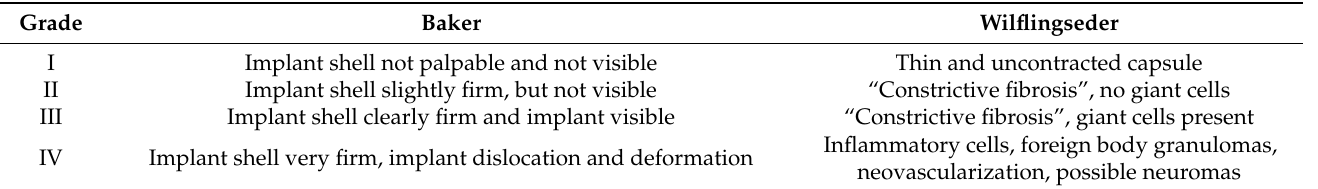
Table 1. Clinical classification (Baker score) and histological classification (Wilflingseder score) of capsular